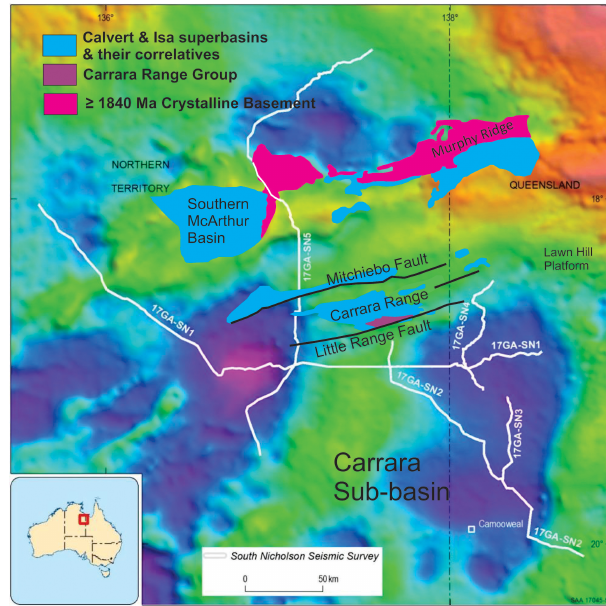
Figure 4. South Nicholson seismic grid and late-Paleoproterozoic– early-Mesoproterozoic basinal sequences draped over gravity im- age for western extension of the Lawn Hill Platform into the North- ern Territory. Note anomalously deep gravity low centred on the Carrara Sub-basin (Carr et al., 2019), which is bounded by the Carrara Range (gravity high) to the north of line 17GA–SN1. Geology modified from Rawlings et al. (2008) and Ahmad and Munson (2013). Gravity image reproduced with permission